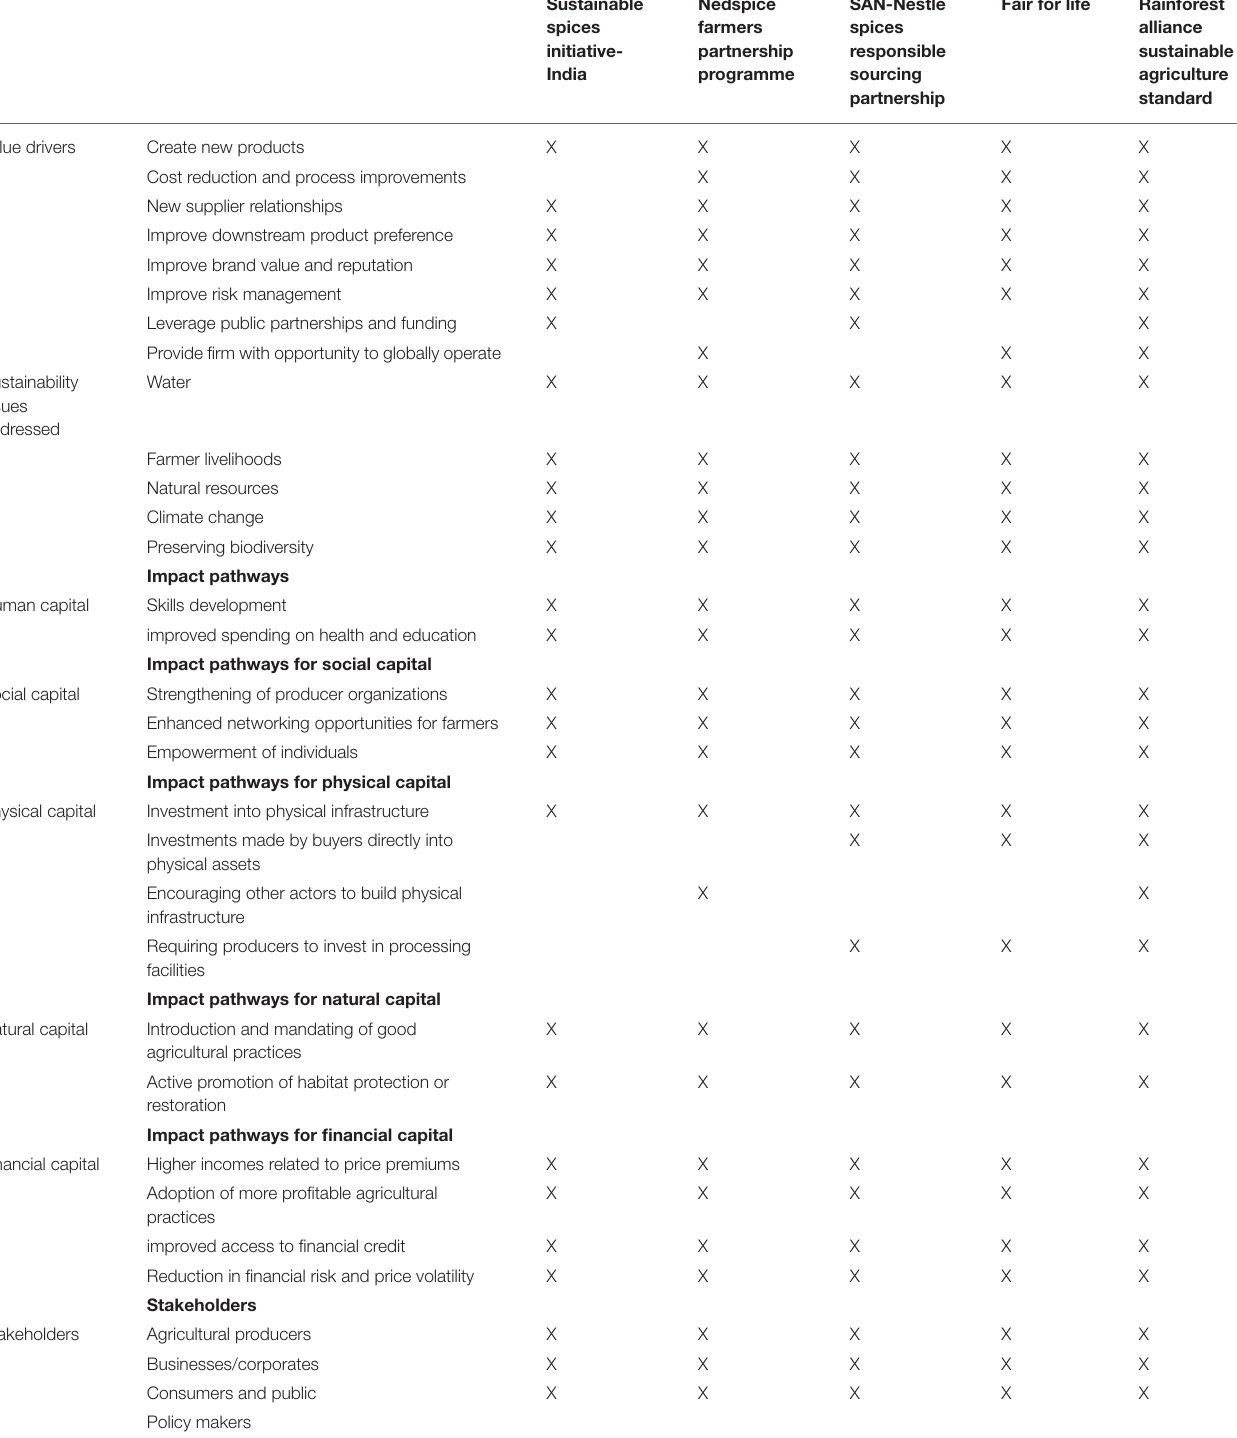
a The crosses are used to signify if the said certification standard fulfills the respective